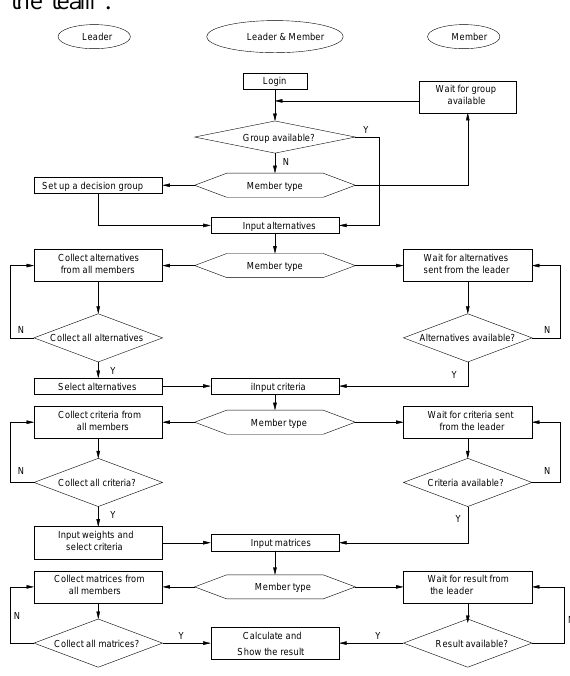
Fig. 1. Flow chart for the WFGDSS working